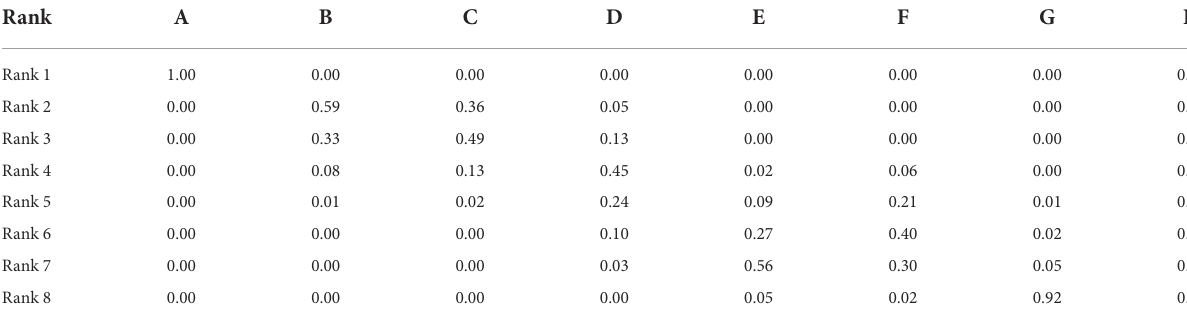
TABLE 3 Ranking probability of different diseases.